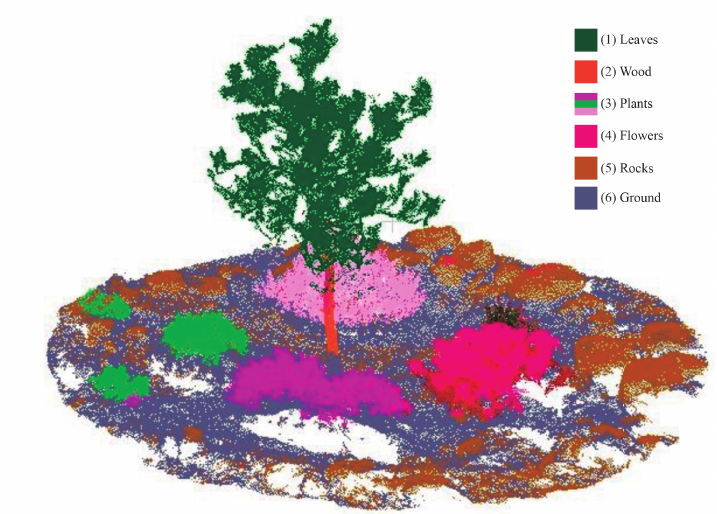
Figure 10. The semantic segmentation of natural materials in the point